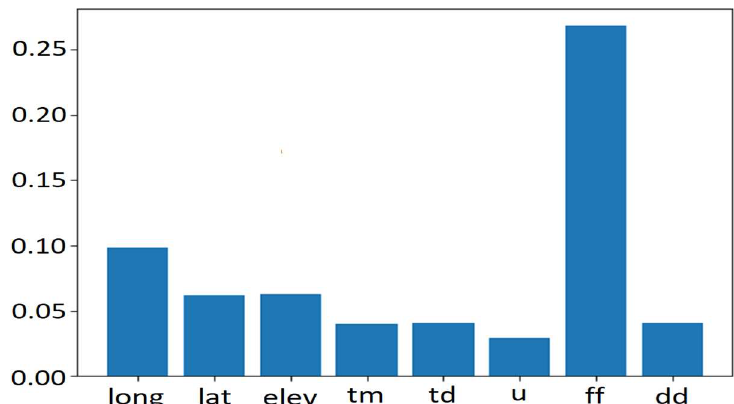
Figure 16. Character significance diagram for the k-NN method.